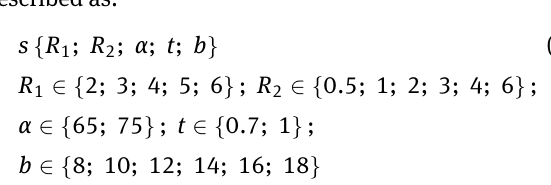
Based on the assumed range of the parameters that de- scribe the geometries of the core’s cross-section, 210 mod- els of the gasket’s design were generated. Examples of the solutions are presented in Figure 5.